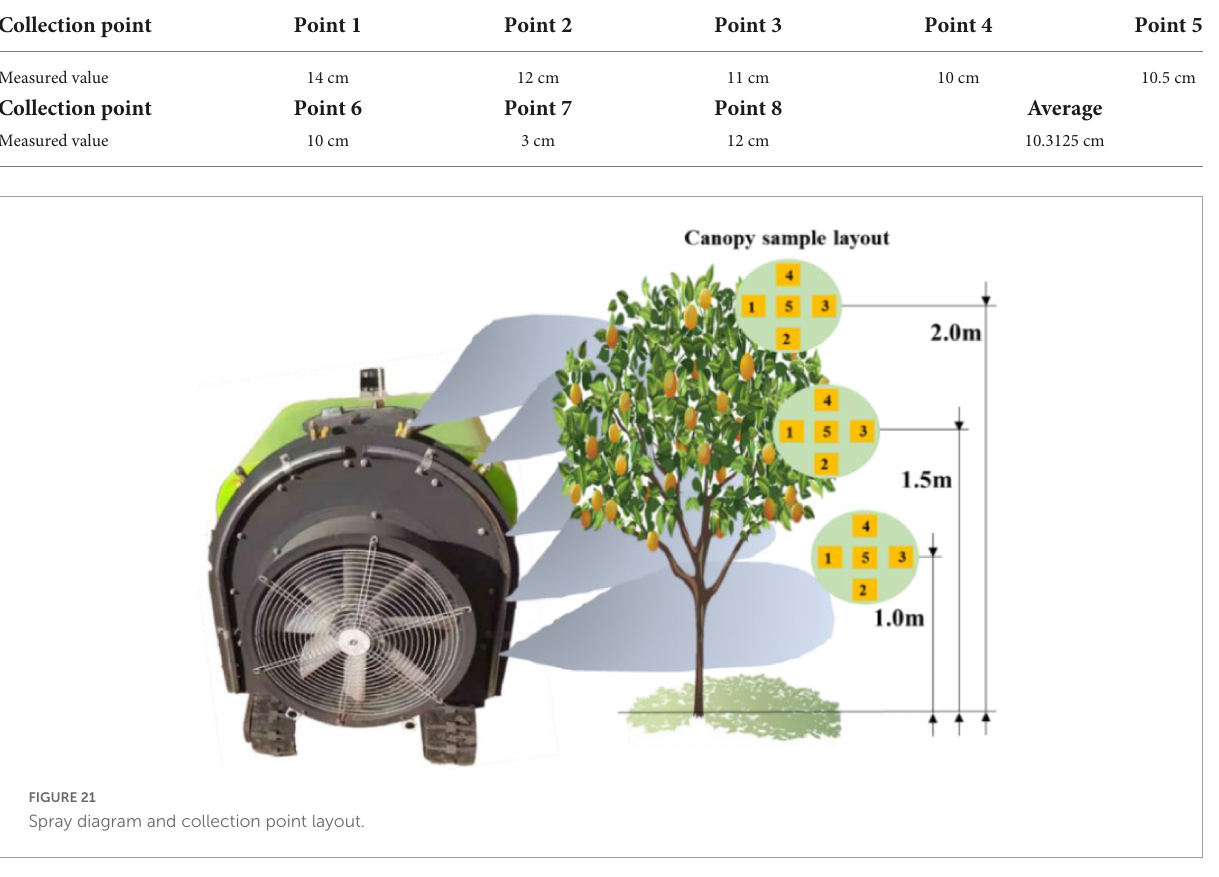
TABLE 6 Coverage of each sampling area under different